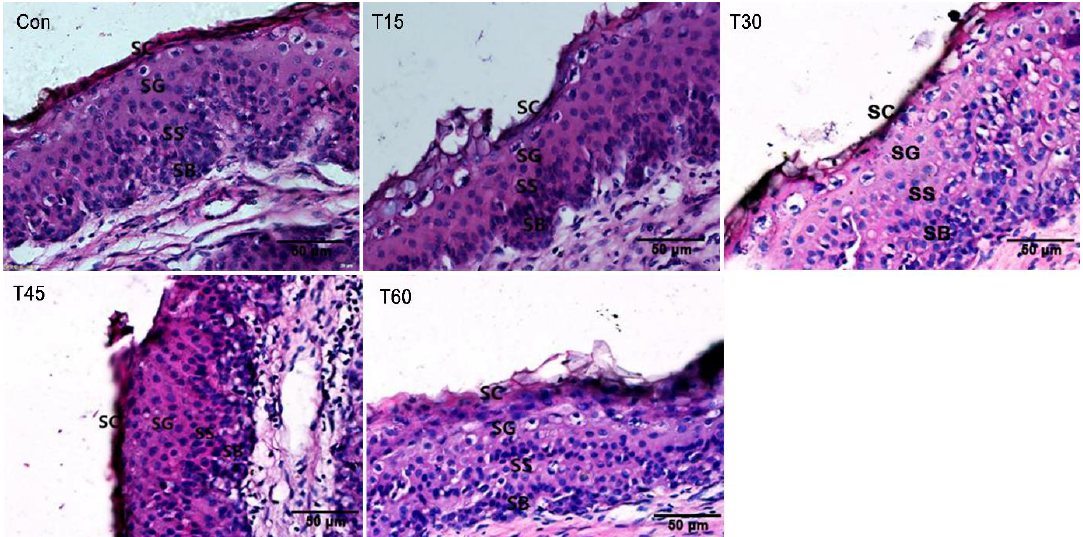
Figure 1. Morphometric variables of rumen epithelium structure in fattening Hu sheep fed with mulberry leaf powder. SC = Stratum corneum; SG = Stratum granulosum; SS = Stratum spinosum; SB = Stratum basale. a,b,c Bar chart within same epithelium structure with different superscripts differ significantly at p ≤ 0.05.